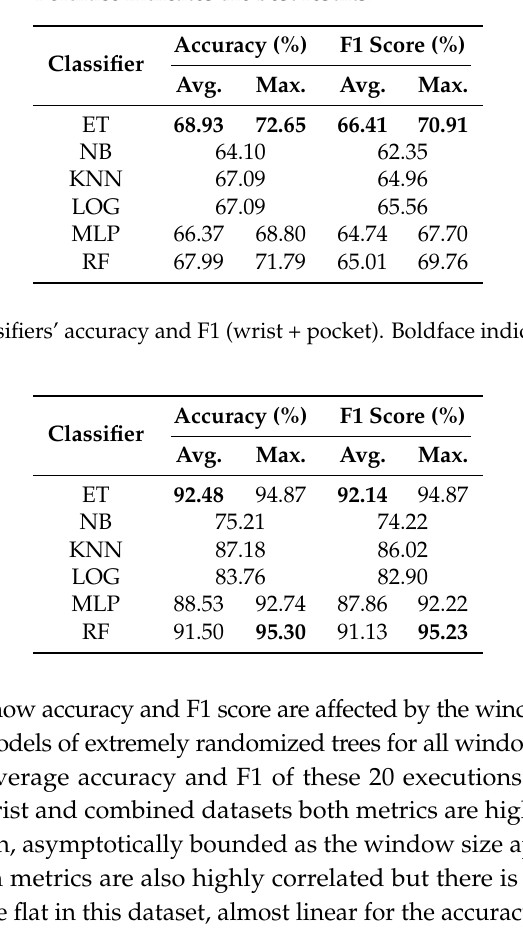
Table 4. Classifiers’ accuracy and F1 (pocket). Boldface indicates the best results.